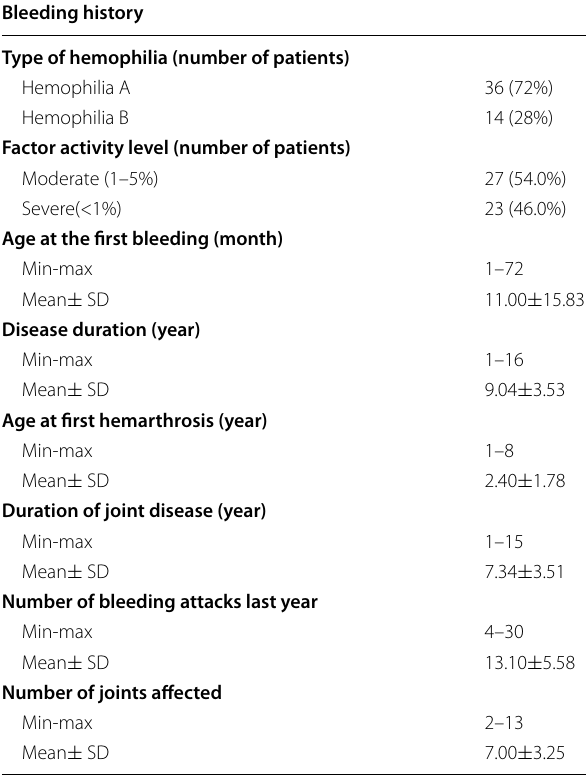
Table 1 Distribution of hemophilic patients according to bleeding